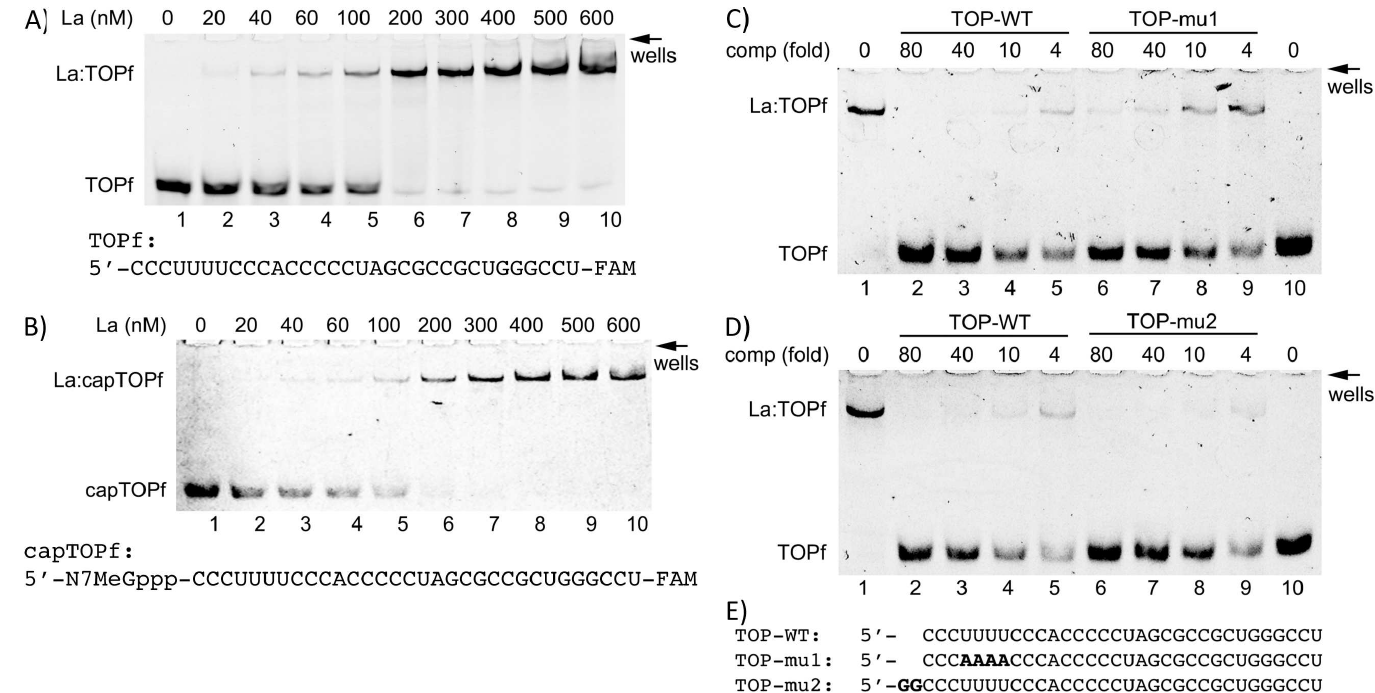
Fig 3. Characterization of La binding to the TOP element of RPL5 mRNA. A) and B) Comparisonof La bindingto TOPf- or 5’ cappedTOPf-RNA (capTOPf) oligonucleotide (50 nM). Recombinant La-WT was titrated into bindingreactionscontain fluorescence labeledTOPf-RNA (A) , or fluorescence labeledcapTOPf-RNA (B) oligoribonucleotides(both at 50 nM) and analyzedon a 10% native polyacrylamide gel. Representative gels of independent experiments are shown. C) and D) Competition experiments using three different RNA oligonucleotides (E) . Recombinant La-WT (100 nM) was used in bindingreactions contain TOPf-RNA (50 nM) and increasingconcentrations of unlabeledcompetitor RNA oligonucleotides: TOP-WT, TOP-mu1 or TOP-mu2. Reactionswere analyzedon a 10% native polyacrylamide gel. E) Sequence of unlabeledcompetitor RNA oligonucleotides used in this study. All experiments were at least performed